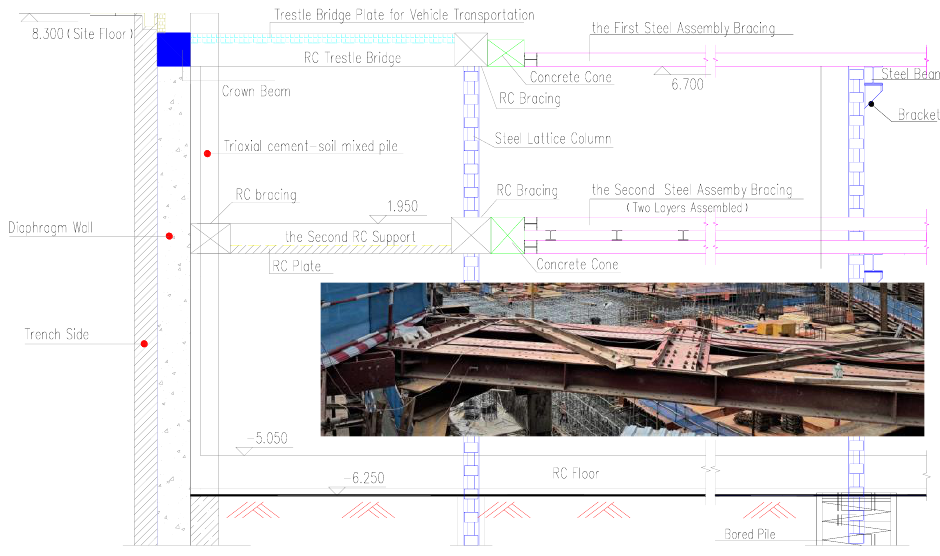
Figure 2. Side view of steel assembly bracing of foundation pit.